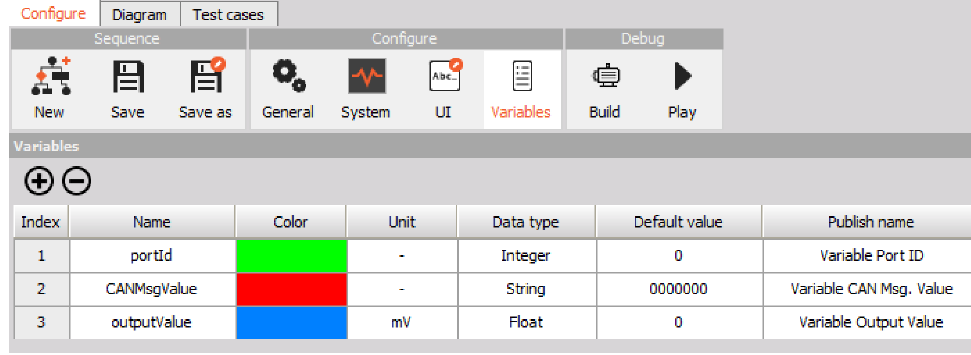
Figure 9. Domain expert perspective on variable definition (channels from data acquisition).